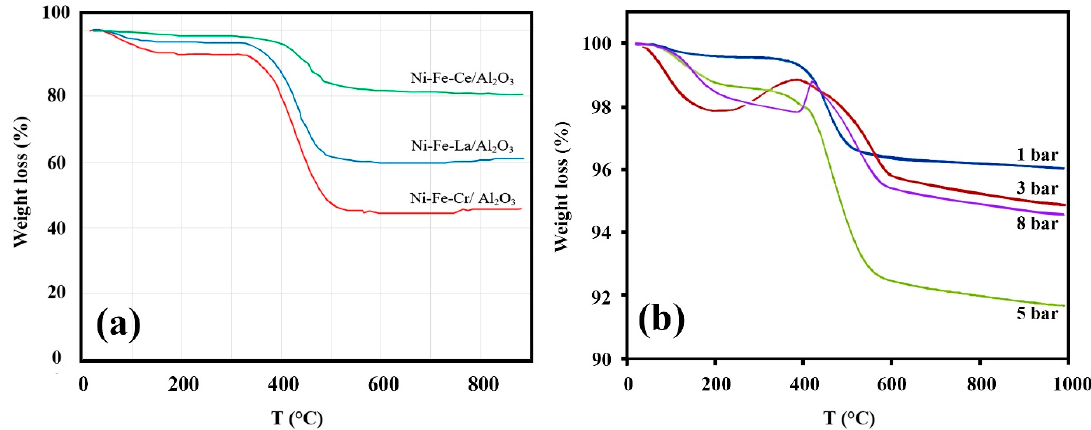
Figure 9. ( a ) TGA graph for ( a ) synthesized Ni-based catalysts at 450 °C and 1 bar, ( b ) used Ni-Fe-Ce/Al 2 O 3 catalyst at 450 °C, and various pressures in the SR of glycerol [85] (redrawn with copyright permission).